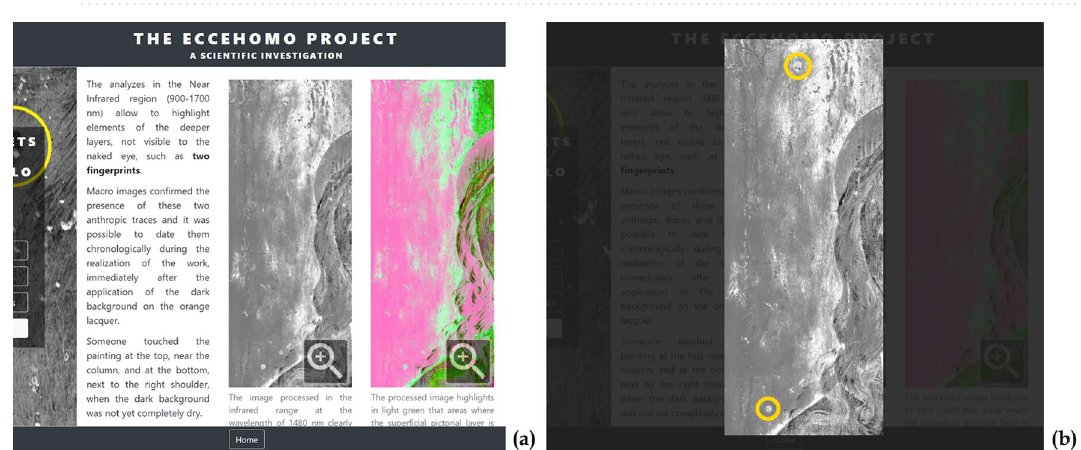
Figure 14. Kiosk panel showing text and images mixed together for presenting to a general public the scientific analysis on the pictorial layers. This figure shows an example of an interactive 2D image enriched with visual elements: by clicking on the image extracted from the short-wave infrared range (SWIR) derivative cube at 1480 nm ( a , grey-level figure), the image is magnified showing the location of the fingerprints ( b